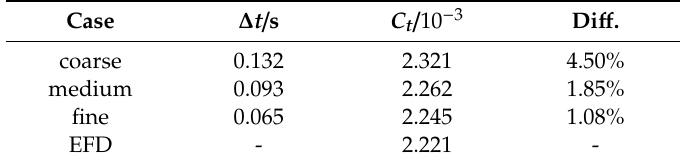
Table 9. The total resistance coe ffi cients of the di ff erent time steps of the full-scale KCS.